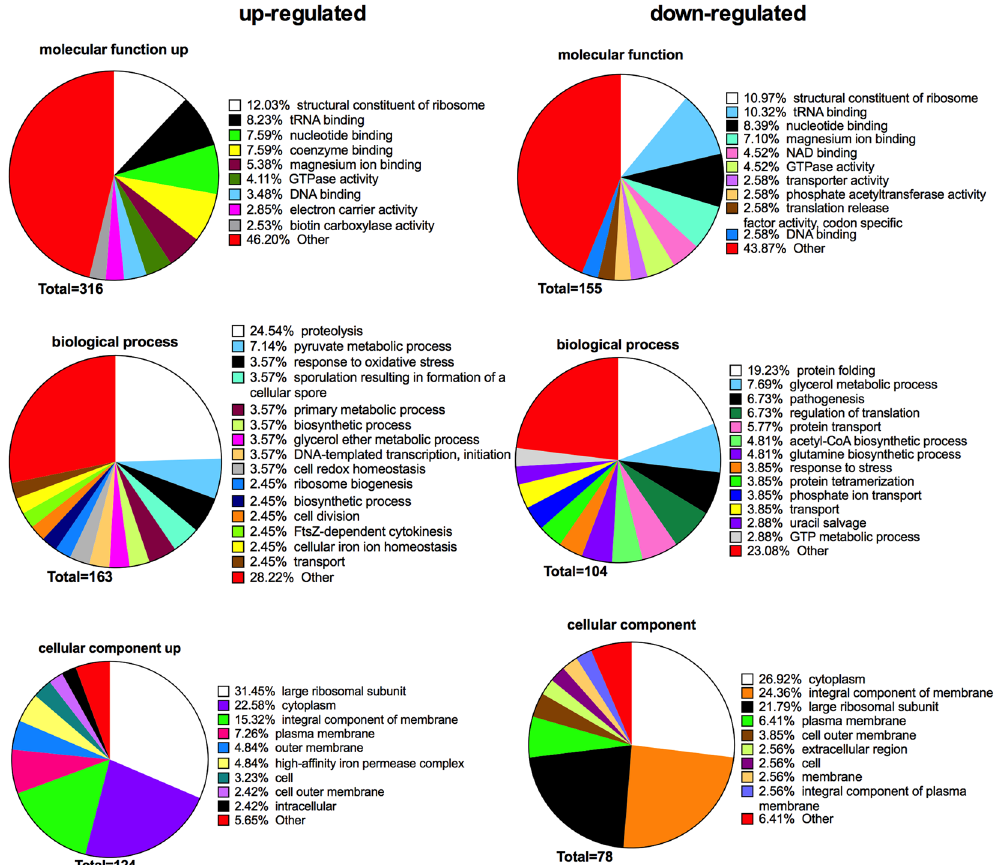
Figure 5. Annotation of regulated bacterial protein functions by Gene Ontology (GO) terms enrichment. The comparison was performed between the two biofilm variants. The GO terms from all regulated bacterial functions were categorized into three categories: a) biological process, b) molecular function, and c) cellular component, as displayed in the pie charts. These categories are displayed as “upregulated” or “downregulated” in relation to the presence of A. geminatus in the biofilm. The numbers of GO terms for each of the three categories are shown, whereas the proportion of each specific subcategory is also provided. Subcategories with GO terms less than 2% are classified as